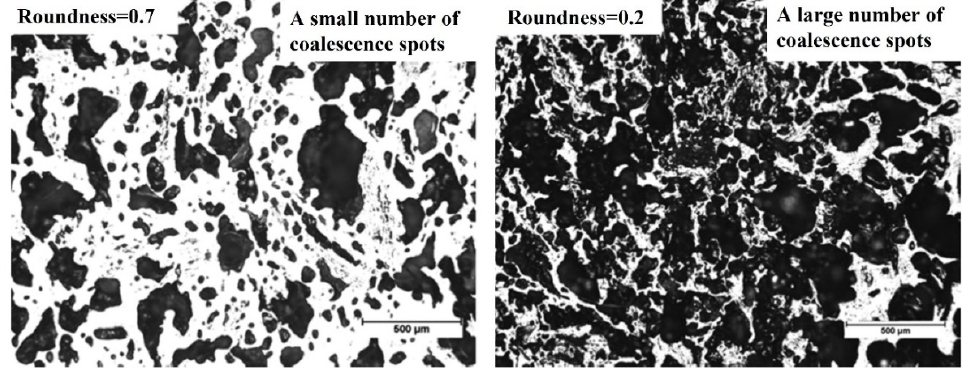
Figure 9. An example of the determination of pore parameters in a coke matrix [70].